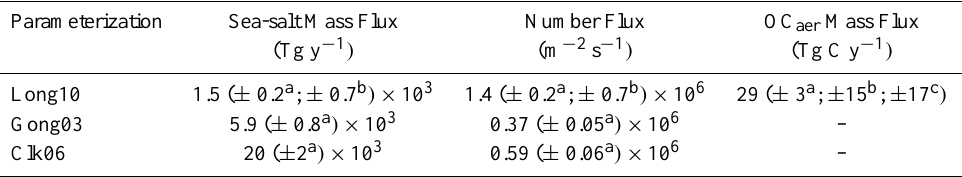
Table 3. Average annual emission fluxes of sea-salt mass, total aerosol number, and OC aer based on CAM (v3.5.07) simulations using different production